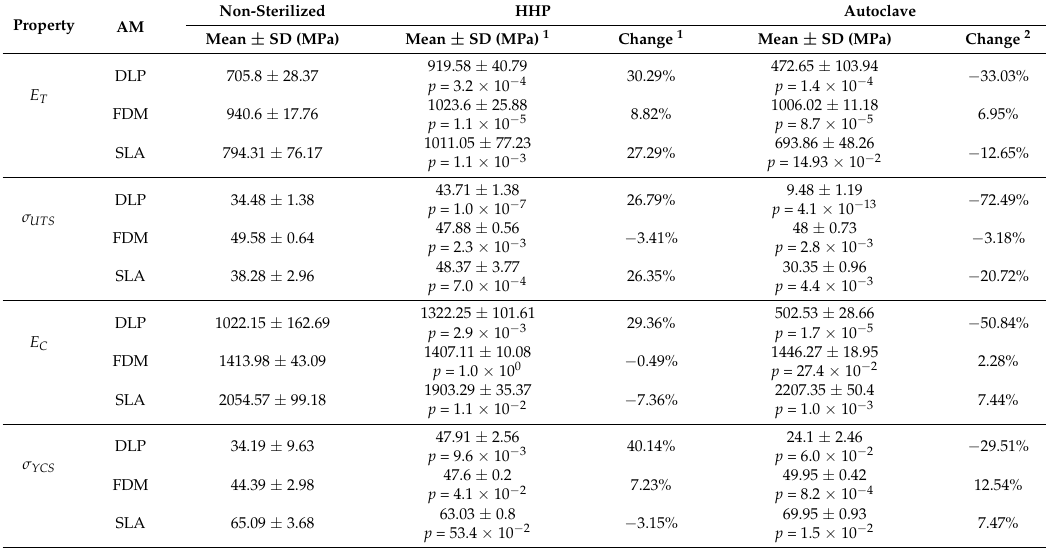
Table 1. Mechanical properties obtained from the mechanical tests of specimens manufactured with DLP, FDM, and